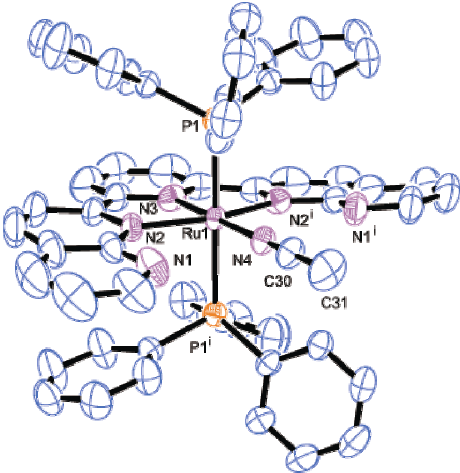
Figure 3. Molecular structure of the cation in complex 2 . Counteranions and hydrogen atoms are omitted for clarity.